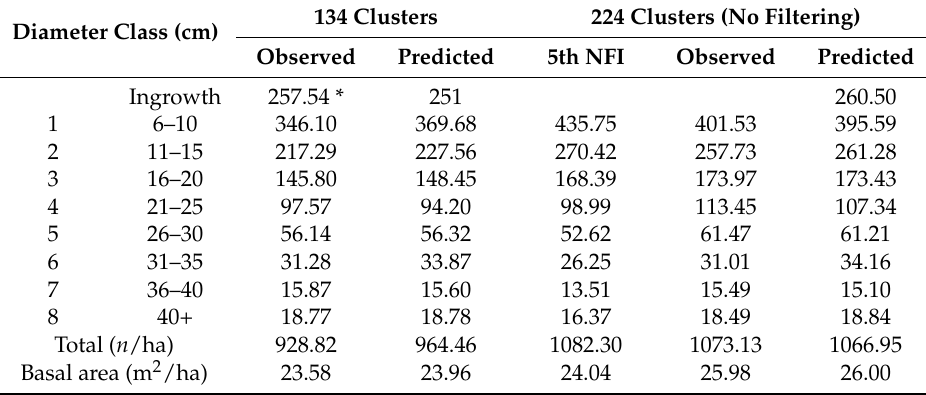
Table 3. Short-term